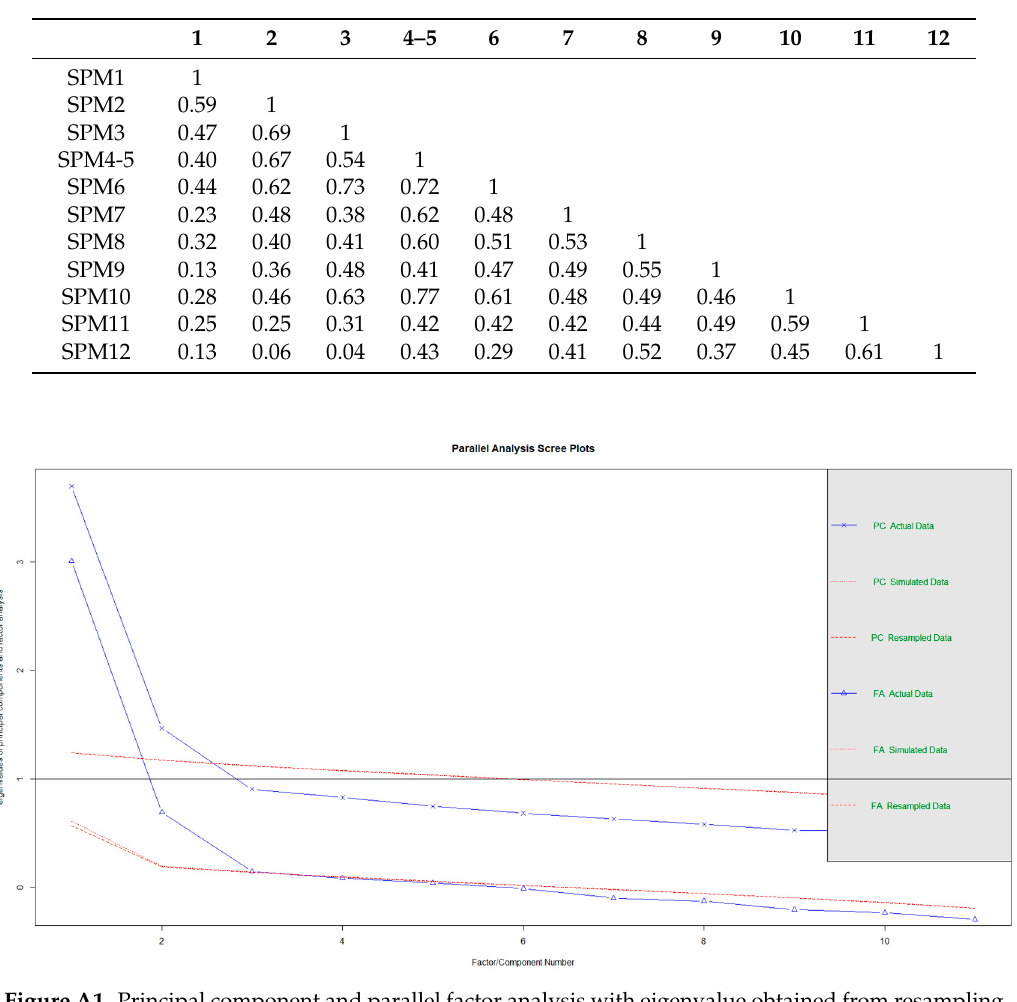
Figure A1. Principal component and parallel factor analysis with eigenvalue obtained from resampling from original data using a parcel for SPM4 and SPM5 items.